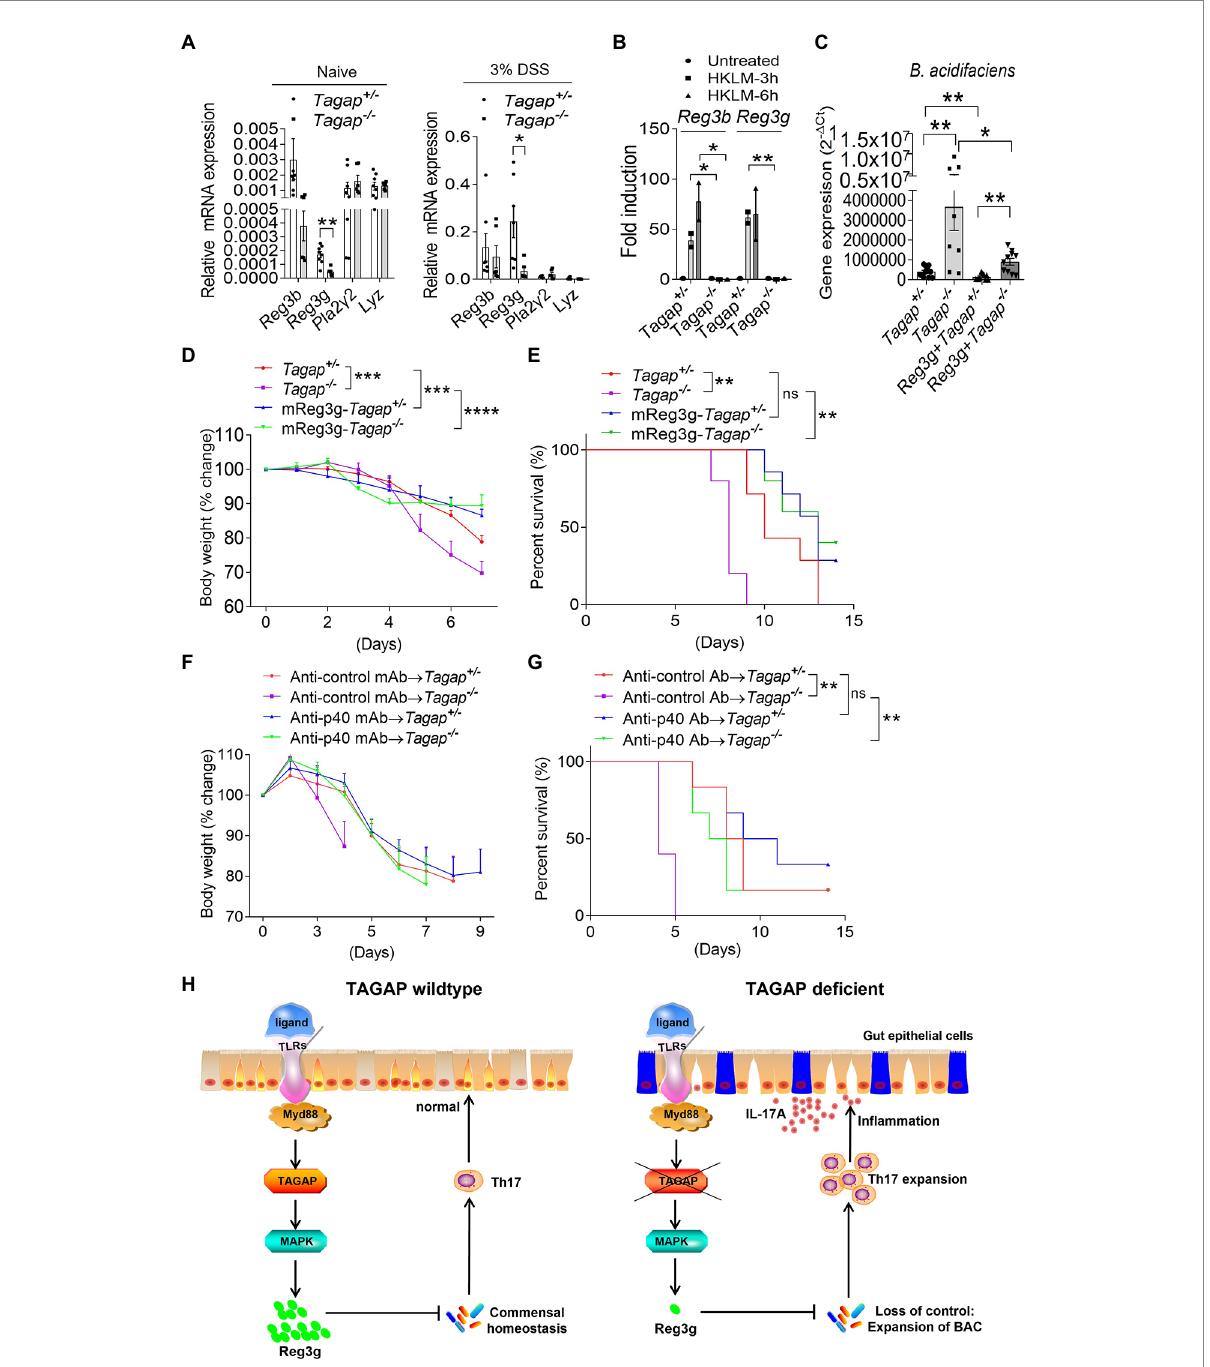
FIGURE 6 Reg3g recombinant protein or anti-p40 MAb rescue the severe phenotype of TAGAP-deficient mice in colitis. (A) Colonic tissues were isolated from littermate control mice or TAGAP-deficient mice with or without DSS treatment (day 5 of DSS treatment), followed by real-time PCR analysis of indicated gene expression, n = 7. (B) Colonic tissues isolated from littermate control mice or TAGAP-deficient mice were treated with HKLM for 3 or 6 h, followed by real-time PCR analysis of indicated genes. (C) Littermate control mice or TAGAP-deficient mice were oral gavaged with recombinant reg3g proteins daily for 1 week (5 μ g/mouse/day), and feces were collected and analyzed by real time PCR for the indicated bacterial strains, n = 12, 8, 10 and 10. (D,E) Littermate control mice or TAGAP-deficient mice were oral gavaged recombinant reg3g proteins daily for 4 weeks (5 μ g/mouse/day), followed by 2.5% DSS treatment for 5 days. Mice weight curve (D) and survival curve (E) were done in separate experiments, n = 7. (F,G) Littermate control mice or TAGAP-deficient mice were intraperitoneal injected anti-control MAb or anti-p40 MAb at day 1, 3, 5 and 7 after DSS treatment (100 μ g/100 μ l 1 × PBS/mouse). Mice weight curve (F) and survival curve (G) were done in separate experiments, n = 6. (H) Model of TAGAP regulating gut microbiota and Th17 cells abundance in the gut, and affecting IBD susceptibility. * p < 0.05, ** p < 0.01, *** p < 0.001, **** p < 0.0001 based on 2-way ANOVA (D,F) , Log-rank (Mantel-Cox) Test for panels (E,G) and unpaired T test (A–C) . Data are representative of three independent